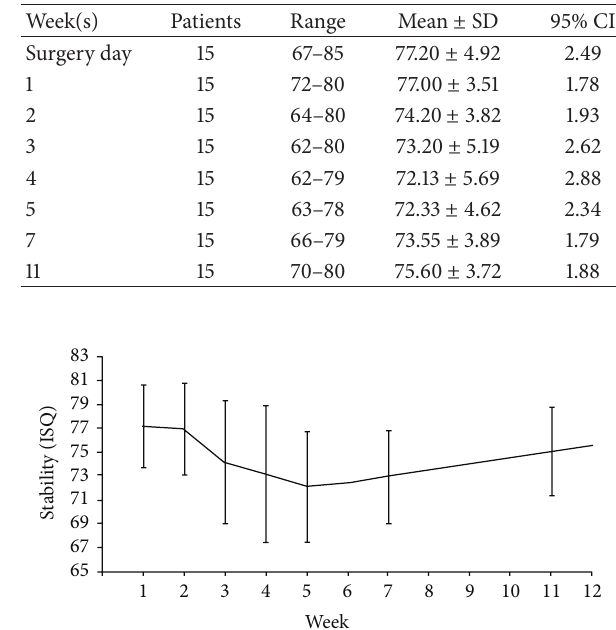
Table 1: The mean ( ± standard deviation) of the stability values measured using resonance frequency analysis for 15 implants weekly until the 5th week and then at the 7th and 11th weeks after- placement.